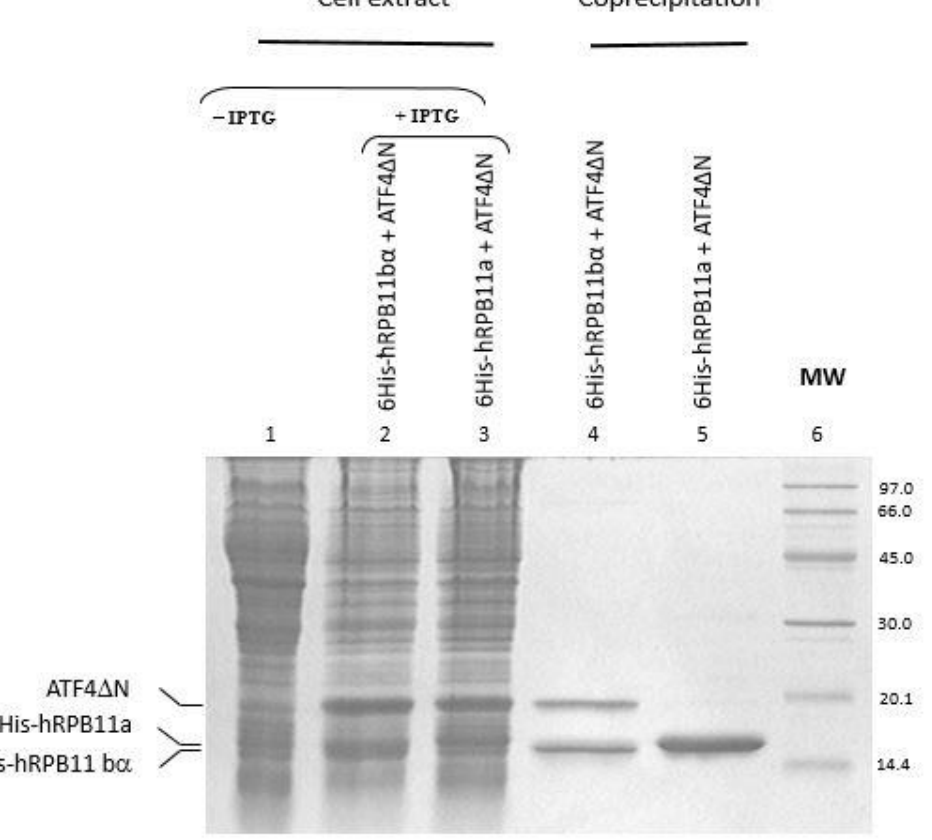
Figure 2. Co-precipitation of hRPB11bα and hRPB11a isoforms of RNA polymerase II subunit POLR2J (hRPB11) with ATF4 after their heterologous expression in E. coli cells (in vitro interaction of hRPB11bα and ATF4 proteins). Fifteen percent SDS-PAGE analysis of the proteins retained on TALON agarose. Recombinant proteins 6His-hRPB11bα (lane 4) and 6His-hRPB11a (lane 5) were immobilized on TALON agarose. Untagged ATF4ΔN protein retains on the agarose if it binds immobilized proteins. MW, molecular weight marker. The gel was visualized by Coomassie Blue R250 staining as described in Materials and Methods.